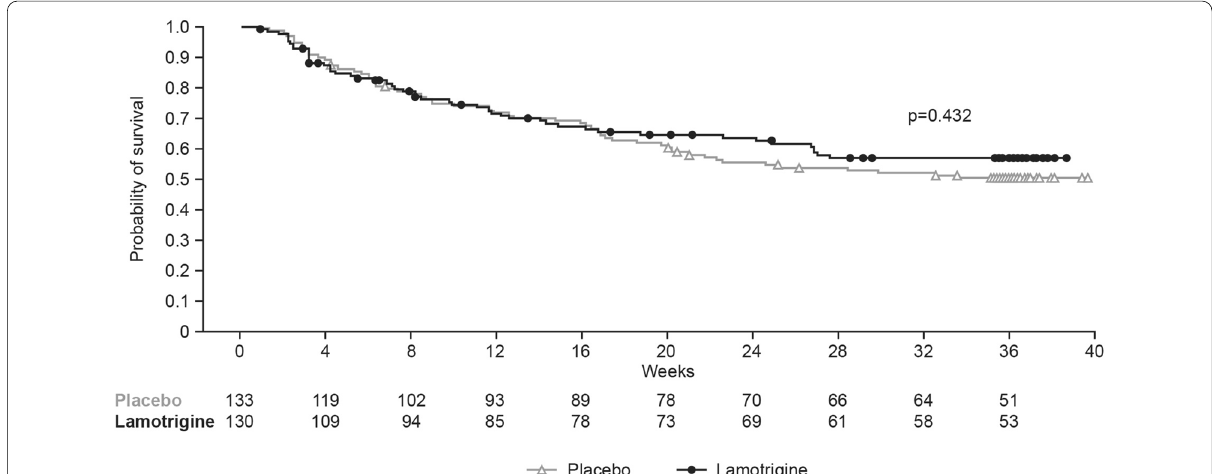
Fig. 2 Kaplan–Meier survival estimates depicting time to intervention for mood episode (TIME). The p value was calculated using the log‑rank test and is for the PBO versus LTG comparison. Marks represent censored events. Estimates are for the RD FAP. FAP, full analysis population; LTG, lamotrigine; PBO, placebo; RD, randomised double‑blind; TIME, time to intervention for mood